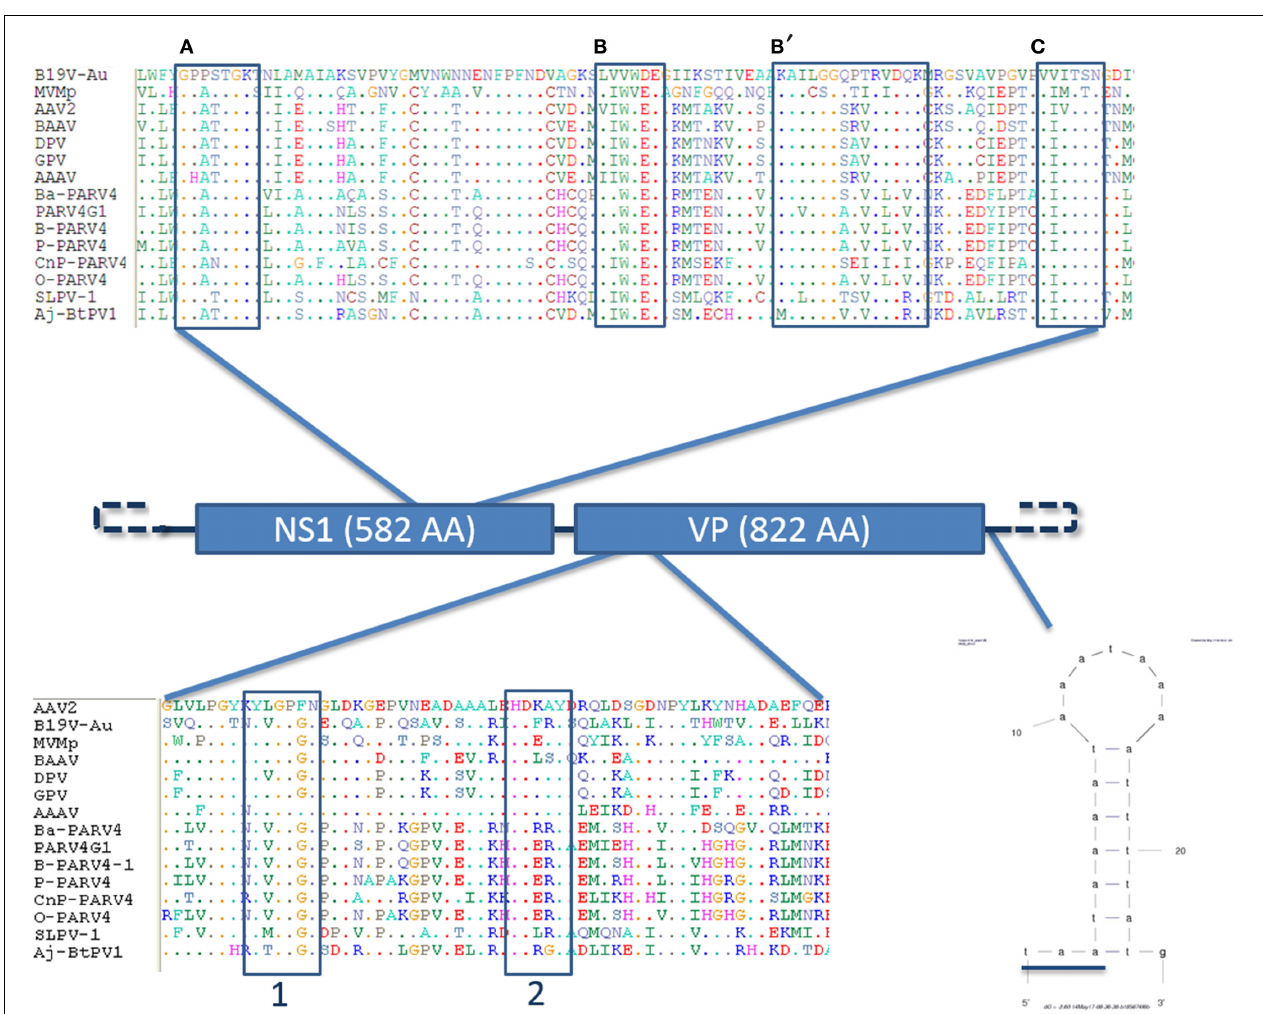
FIGURE 2 | Genome organization of the slow loris parvovirus 1 (Sl.L-PV-1). Schematic representation of the genome organization of Sl.L-PV-1 with the two main ORF (NS1 and VP1) indicated with the respective predicted protein size. On the top the helicase domain of Sl.L-PV-1 (AA 336–423) is compared with the one of other members of the Parvovirinae sub-family. The conserved Walker motifs (A,B,B’,C) are indicated in boxes (Walker et al., 1997; Lou et al., 2012). For sequences accession numbers see Figure 3 . The phospholipase A2 domain comparison between Sl.L-PV-1 (AA